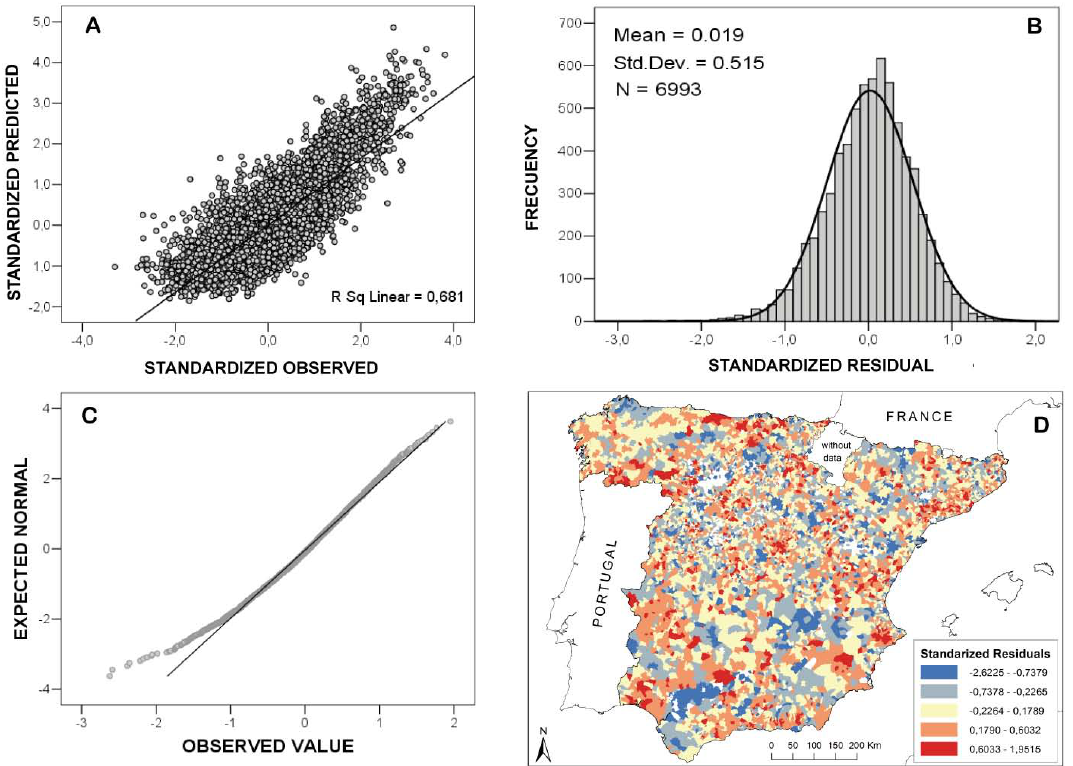
Fig. 5. Residual analysis of the GW linear regression model: scatterplots between observed and predicted observations (A) , histogram data plots of the standardized residuals (B) , normal Q − Q plot of the standardized residuals (C) , and map of the standardized residuals (D)